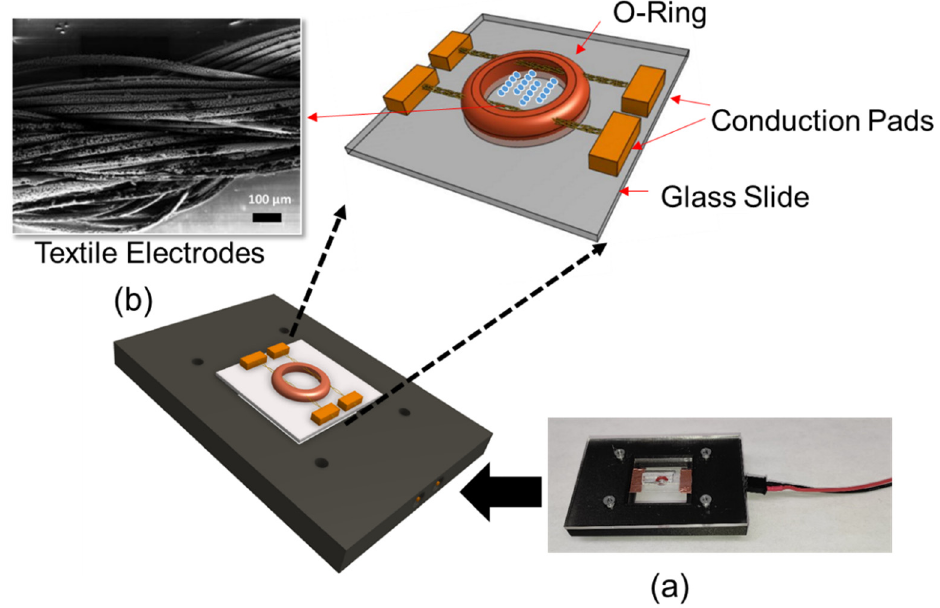
Figure 1. ( a ) Textile electrode-based DEP system with the connection base and ( b ) SEM micrograph of textile electrodes.